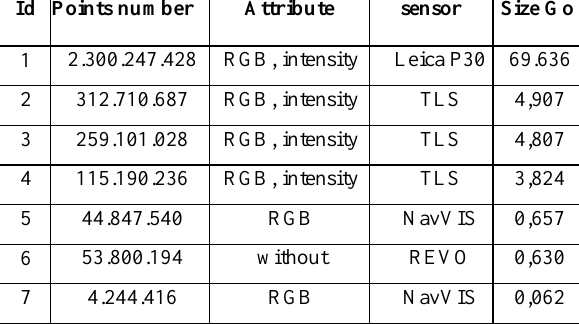
Table 1. Different points clouds to